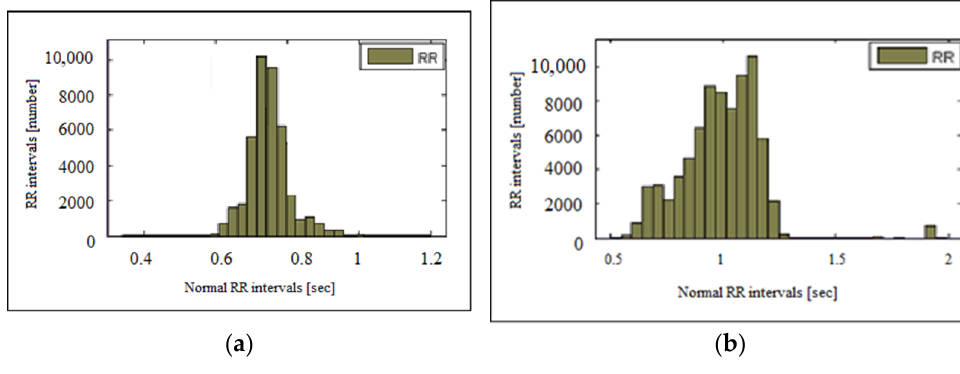
Figure 8. Histogram of: ( a ) heart failure and ( b ) tachycardia.